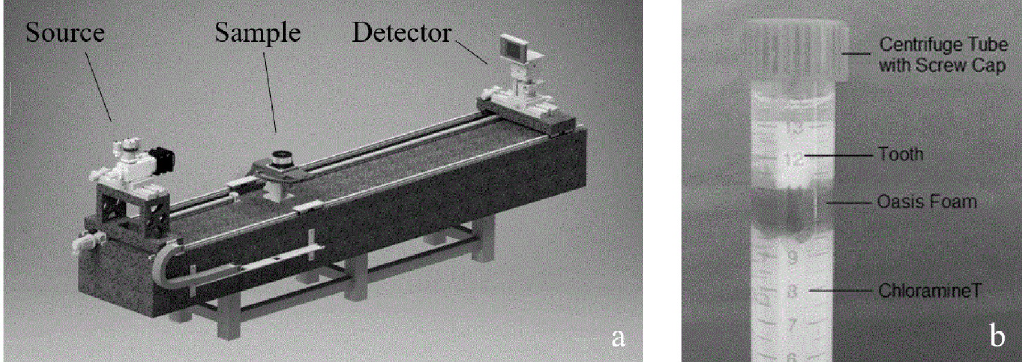
Fig 1. MetRIC (Micro and Region of Interest CT). To create μ -CT images, teeth were scanned with the MetRIC. (a) Schematic image of the MetRIC. With permission from the Institute for X-ray Microscopy, Fraunhofer IIS; Wuerzburg, Germany. (b) Tooth placed on sample holder to acquire μ -CT